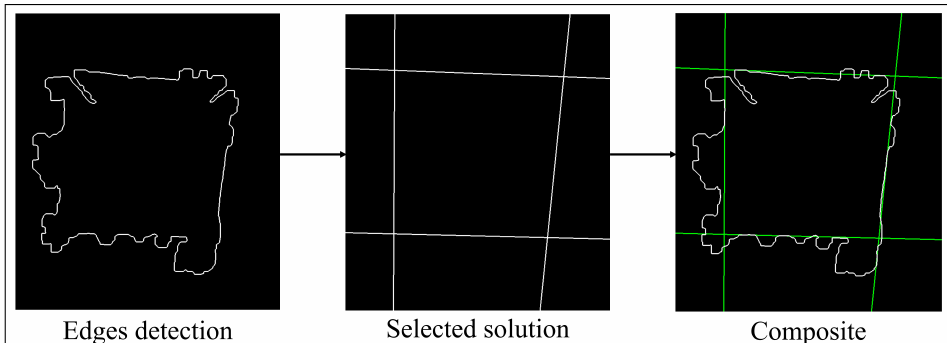
Figure 9. Edge detection and solution selected by the algorithm.